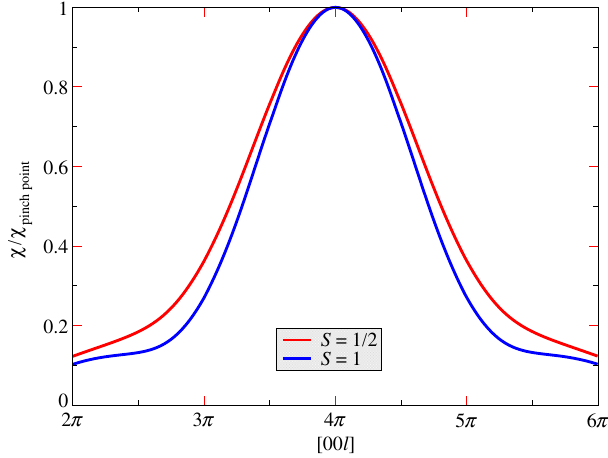
FIG. 7. The susceptibilities of the S ¼ 1 = 2 and S ¼ 1 isotropic nearest-neighbor Heisenberg antiferromagnet plotted along the 1D cut (see the white line in the T=J 1 ¼ 1 = 100 plot in Fig. 6) across the bow-tie width at the lowest simulated temperature T=J 1 = 100 1 ¼